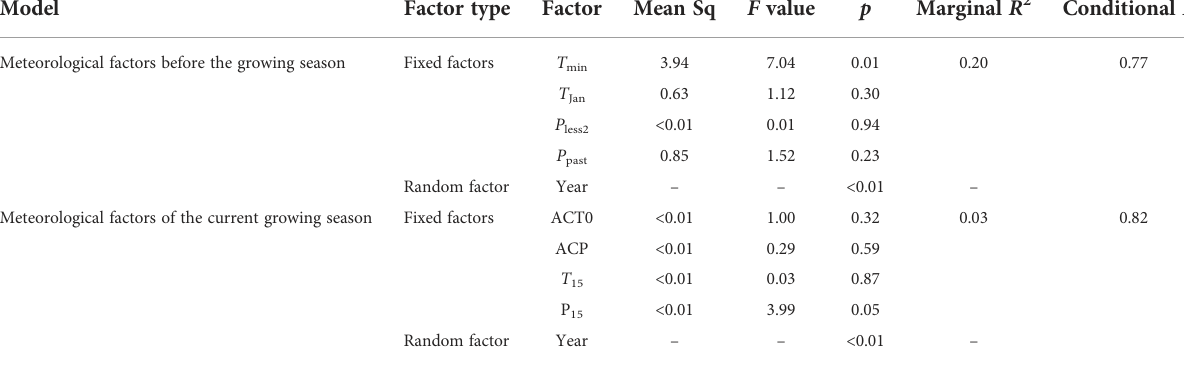
TABLE 3 Linear mixed-effects models (LMMs) between NRI an and meteorological factors.